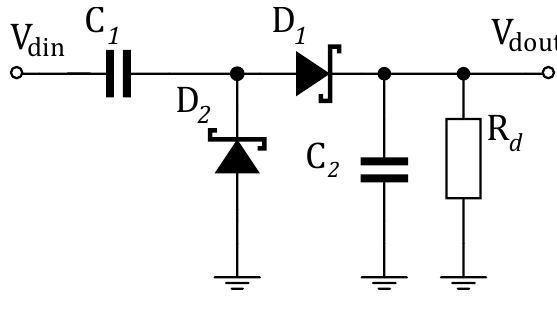
Figure 7. Greinacher voltage doubler as a square-law